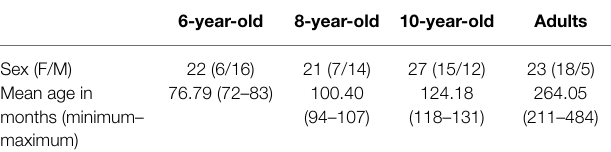
TABLE 1 | Summary of participants’ characteristics in Experiment